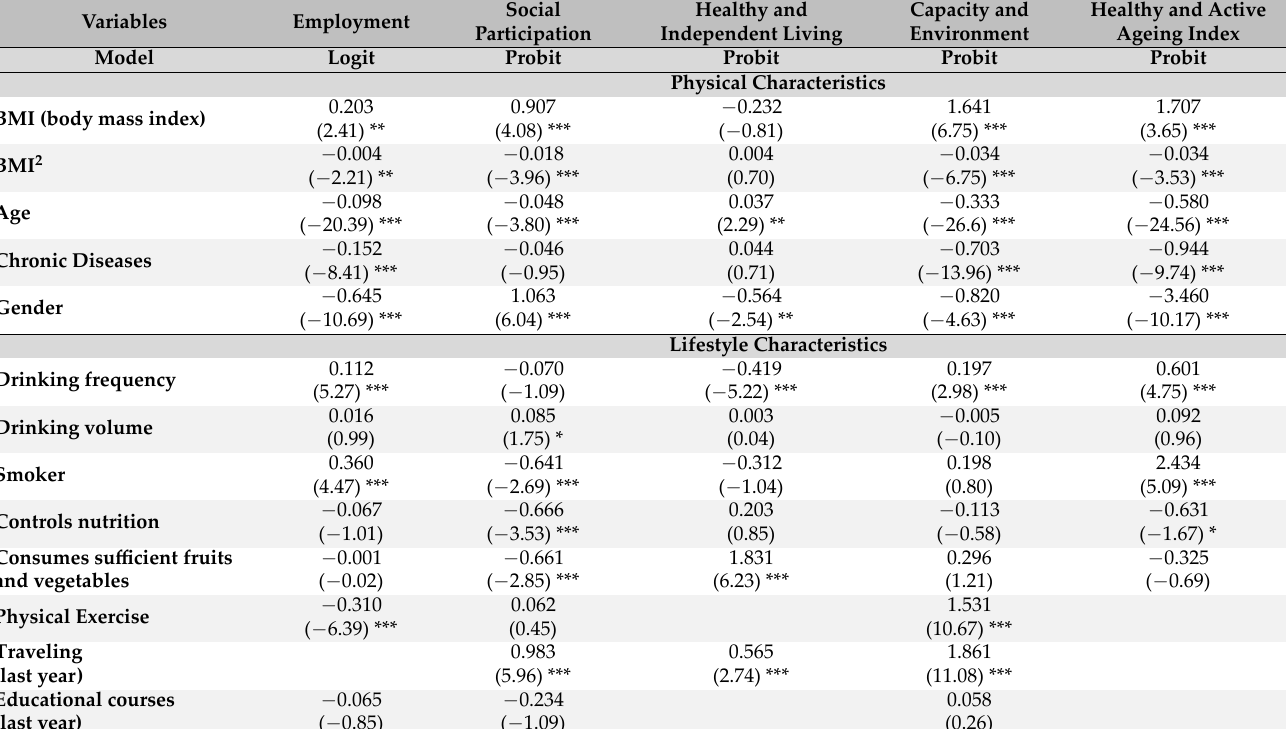
Table 7. Physical, Lifestyle, and Socio‑Economic Determinants of Healthy and Active